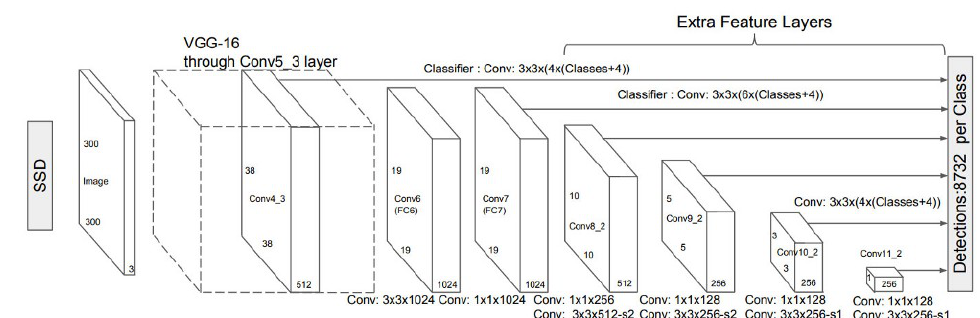
Figure 2. Single Shot Multibox architecture